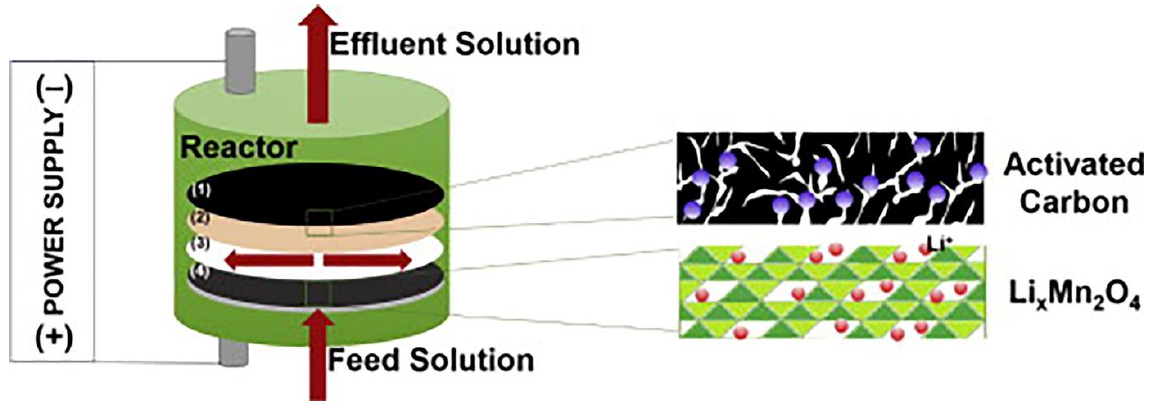
Figure 4. Schematic diagram of the continuous lithium-recovery system: (1) an activated carbon- composite electrode, (2) an anion exchange membrane, (3) nylon as a spacer, and (4) a λ -MnO 2 composite electrode, are contained in the reactor. Reprinted with permission from Ref. [43]. Copyright 2015 Elsevier.